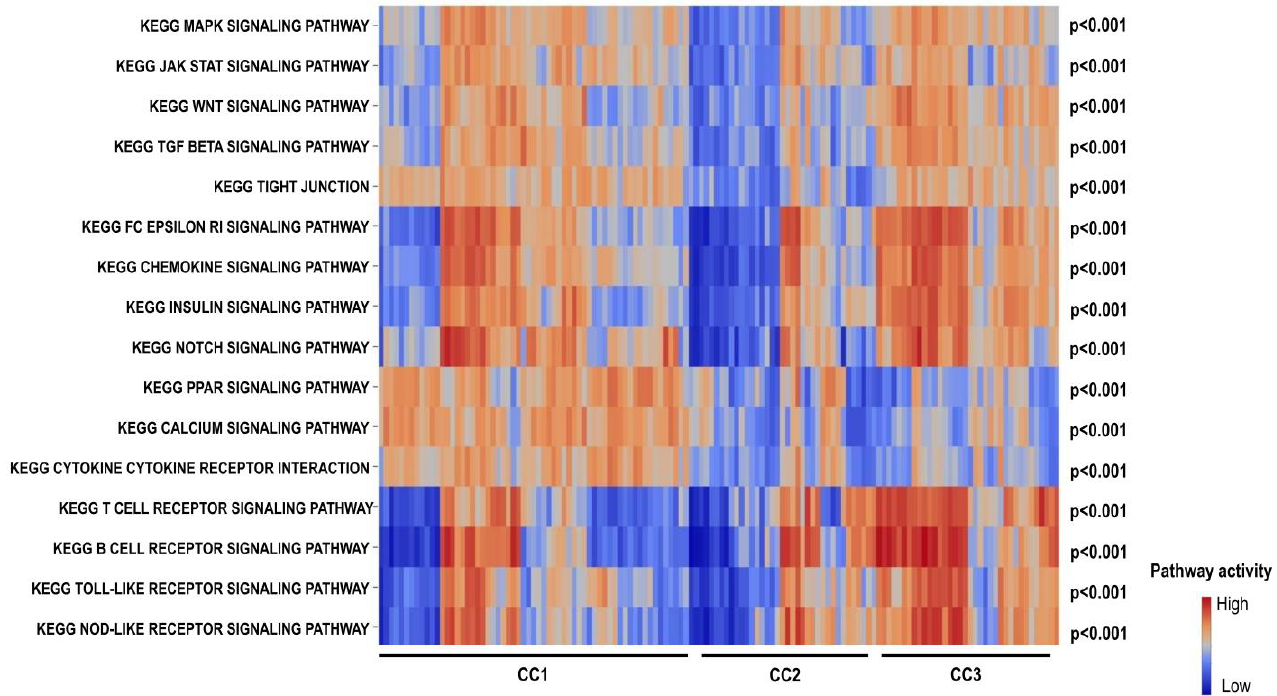
Figure 2. The heatmap demonstrates the activity of each pathway (row) within each patient (column). Samples within each cluster are grouped together, and each pathway is hierarchically clustered by its activity within the CC cluster. Pathway names are shown on the left, while the adjusted p -values of ANOVA tests with Bonferroni correction are shown on the right.